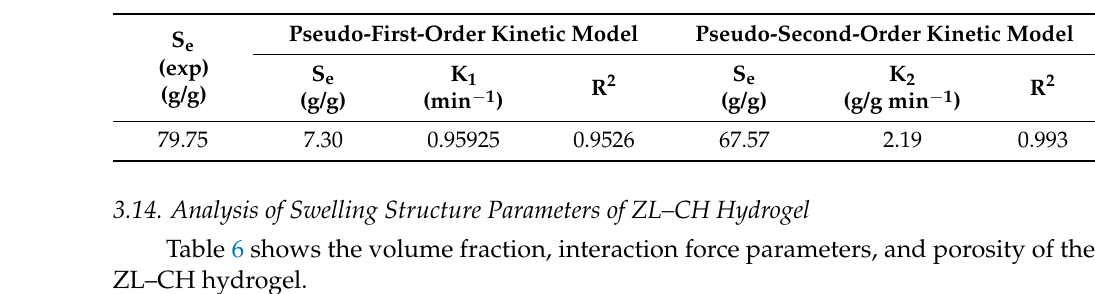
Figure 15. Linear swelling kinetics of AR88 from AR88 loaded ZL–CH hydrogel. ( a ) Pseudo-first- order kinetic model; ( b ) pseudo-second-order kinetic model. Table 5. Correlation and constant coefficients of pseudo-first-order and -second-order kinetic models for the swelling of AR88 from AR88 loaded ZL-CH hydrogel.